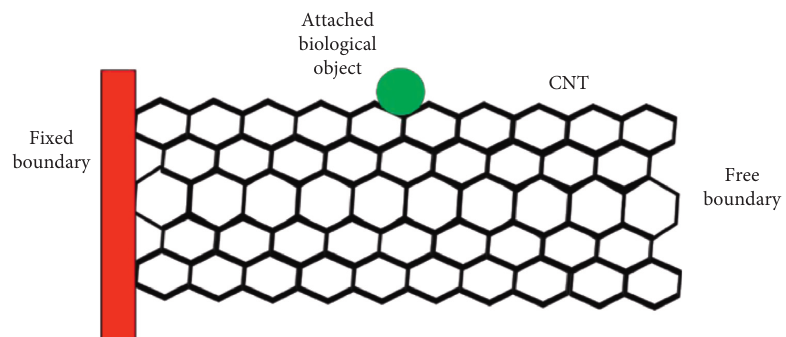
Figure 1: SWCNT with fixed-free boundary condition.